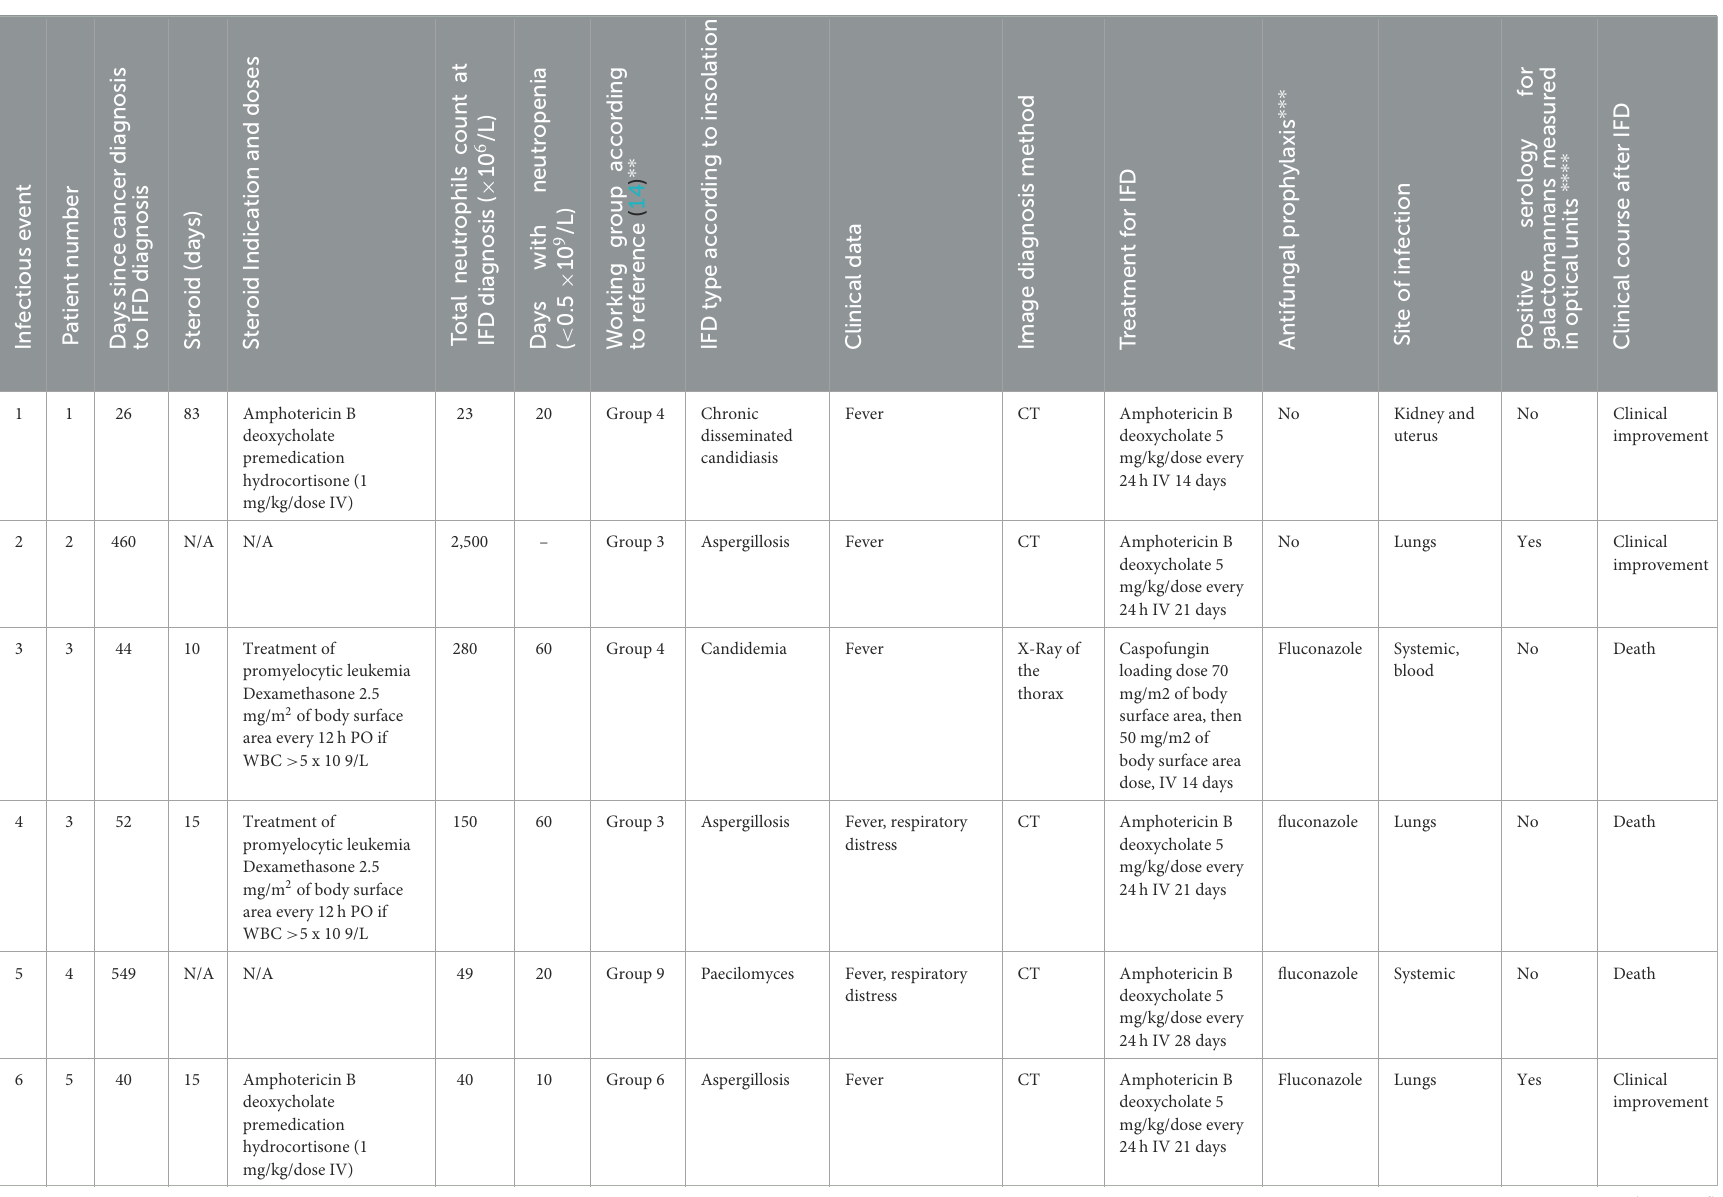
TABLE 2 Clinical course of IFDs in patients enrolled in this